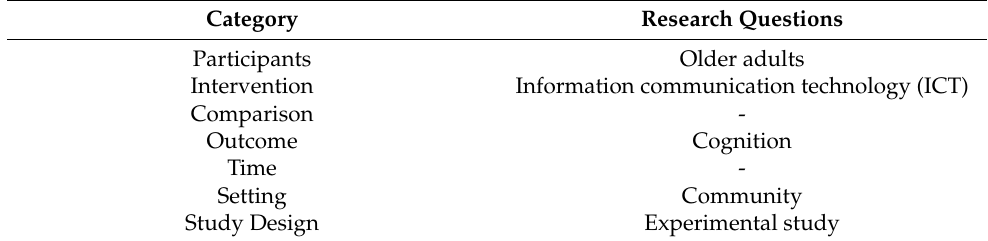
Table 1. Research questions